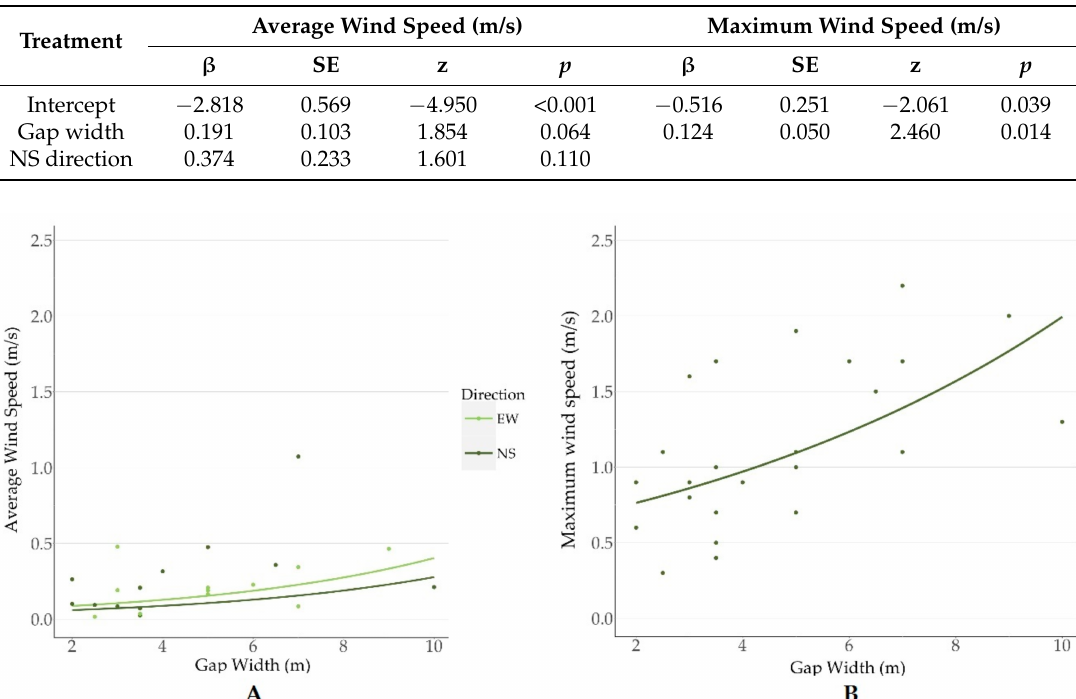
Table 4. Mixed effect regression predicting average and maximum wind speed (m/s) on seismic lines as a function of gap width and direction using a Gamma model transformation. Model coefficients ( β ), Standard Error of the coefficients (SE), z-score (z), and significance ( p ) are reported.